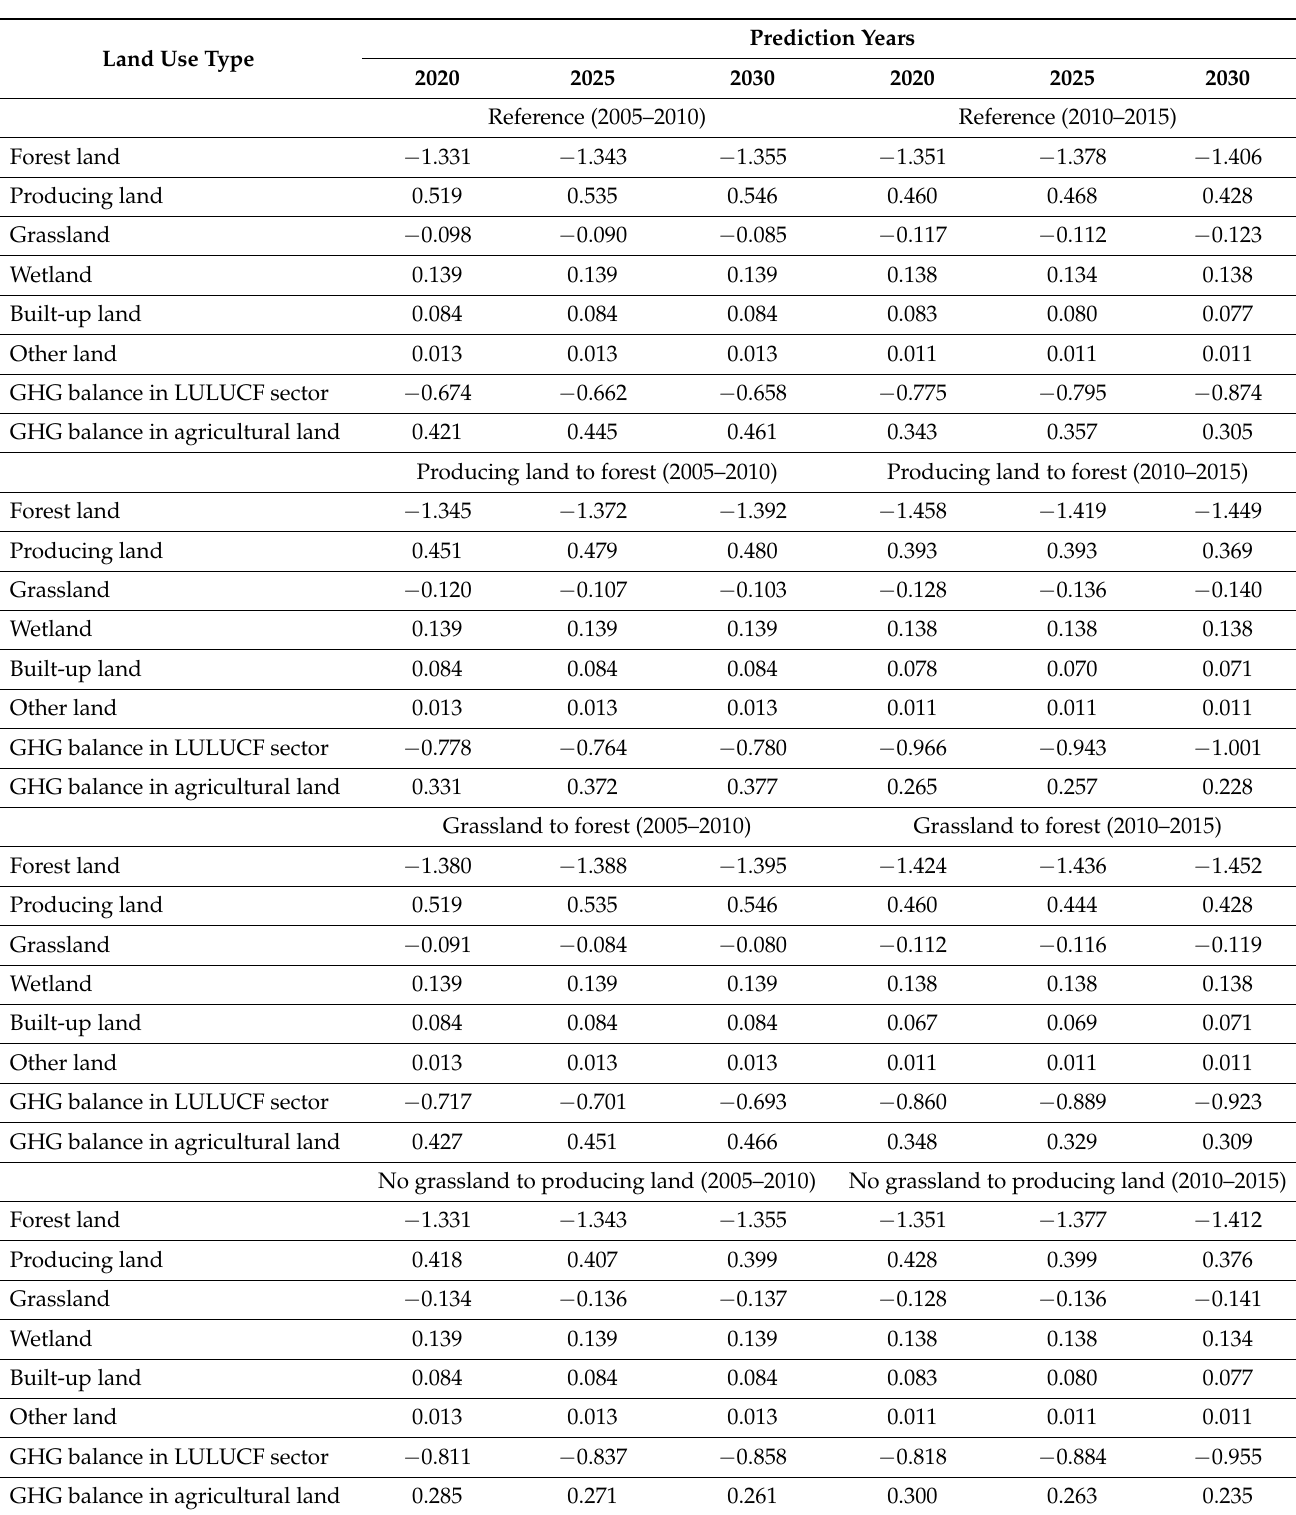
Table A3. Predicted carbon emission and absorption from the LULUCF sector in Lithuania, depending on scenario (numeric values used to build Figure 6, in t CO 2